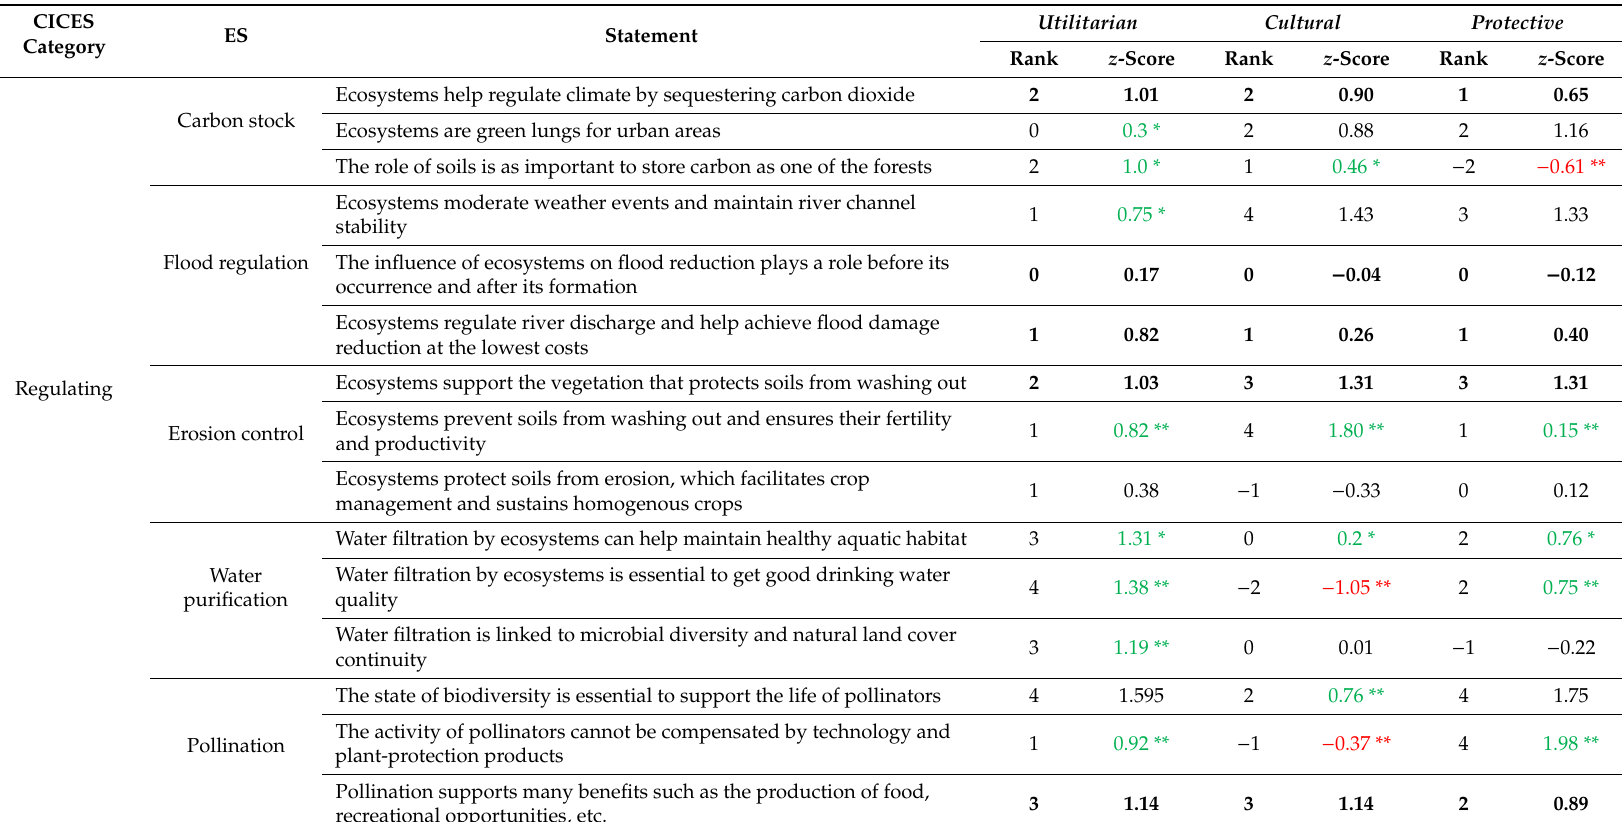
Table 2. Statements comprising the Q-set, their respective rank, and z -scores for each perspective. The most important statements within the perspectives are indicated by higher or lower rank and z -scores. Statements with red z -scores received lower scores and are considered less important. Statements with green z -scores received higher scores and can be considered more important. Distinguishing statements are indicated next to the particular z -scores for each of the perspectives (* for p -value < 0.05, ** for p -value < 0.01). Bold rank and z -scores indicate statement were high levels of agreement among the